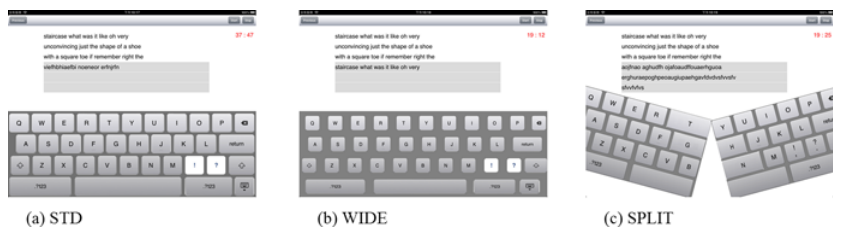
Fig 2. The three different designs of virtual keyboard evaluated. (a) STD design, the default layout provided in the tablet ’ s operation system. (b) WIDE design, the layout with broaden horizontal between-key spacing. (c) SPLIT design, the layout formed by two angled half keyboards